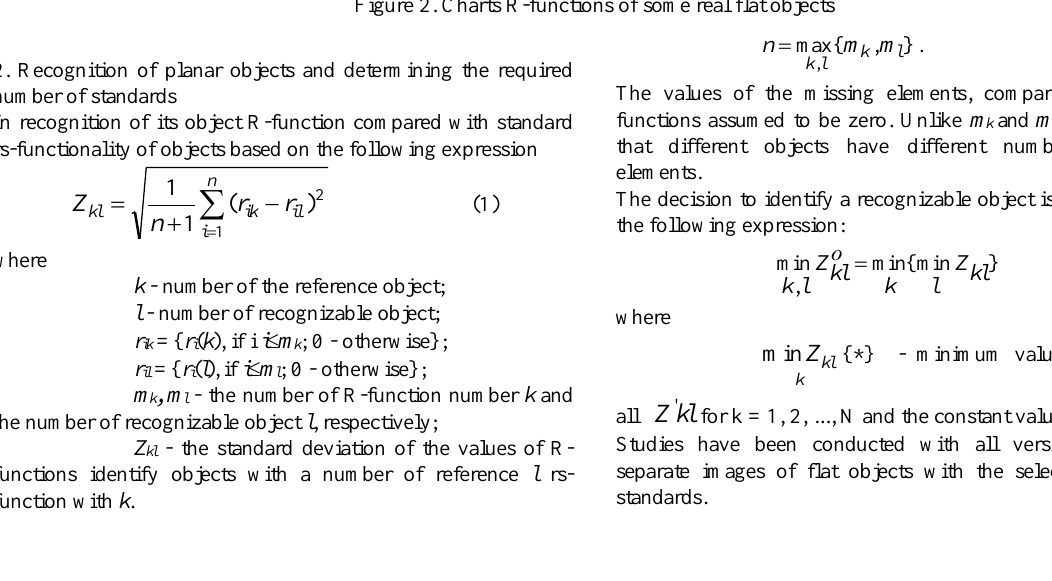
Figure 2. Charts R-functions of some real flat